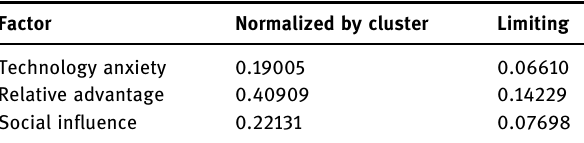
Table 3: Weight of factor cluster Table 4: Weight of relative advantage sub - factor cluster